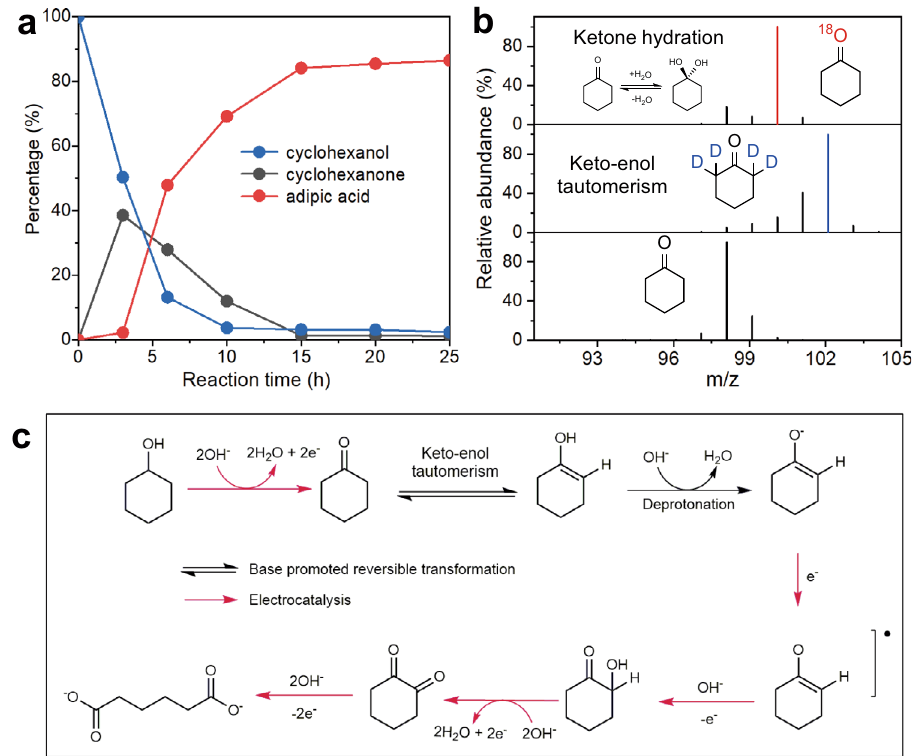
Fig. 6 | Reaction mechanism of KA oil electrooxidation. a Kinetic curves for cyclohexanol electrooxidation over Ni(OH) 2 -SDS in 0.5M KOH with 20mM cyclo- hexanol at 1.5V vs RHE. b Mass spectra of cyclohexanone in